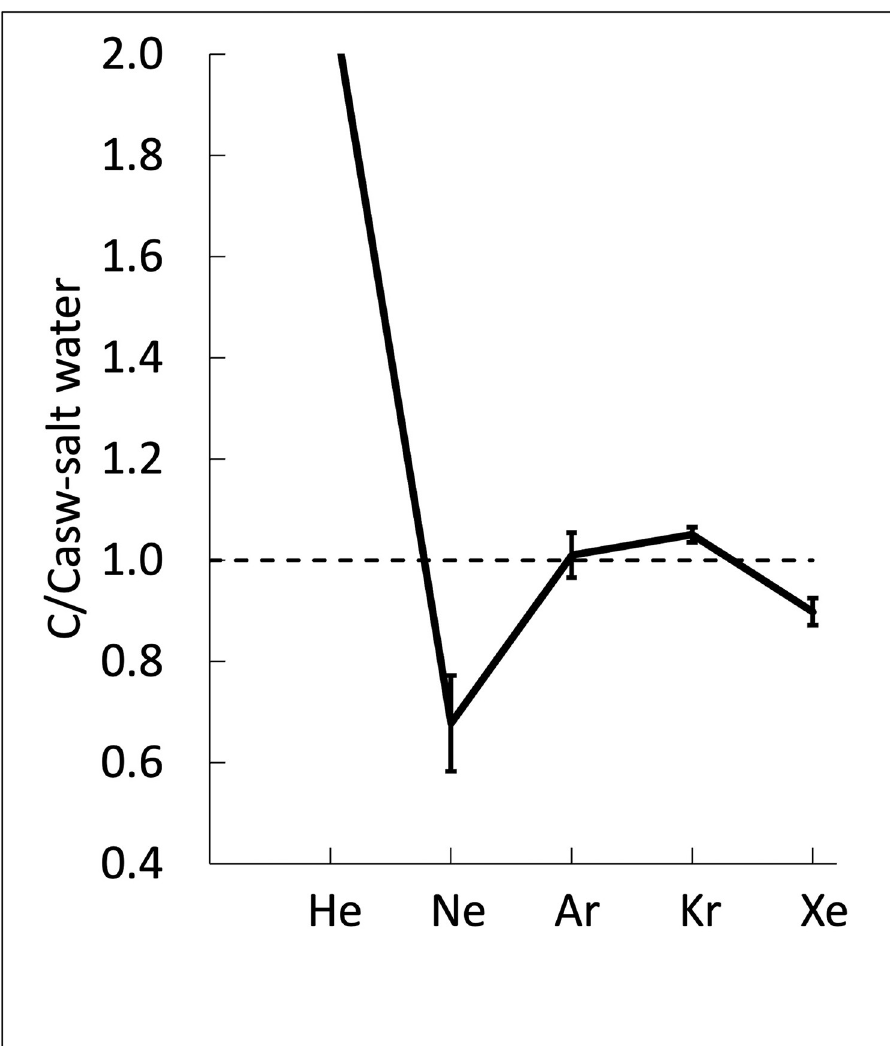
Fig 9. Noble case ratios in the springs normalized to air-saturated values for the saline spring water. The scale does not reach the level of He, which is hundreds of times higher in the spring bubbles than air levels due to He accumulation in the groundwater. Error bars are the standard deviation for four